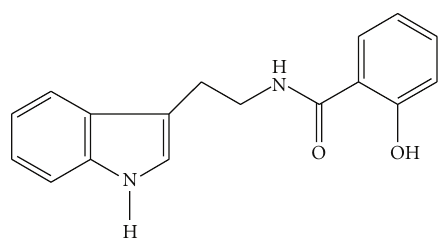
Figure 1: Molecular structure of the N